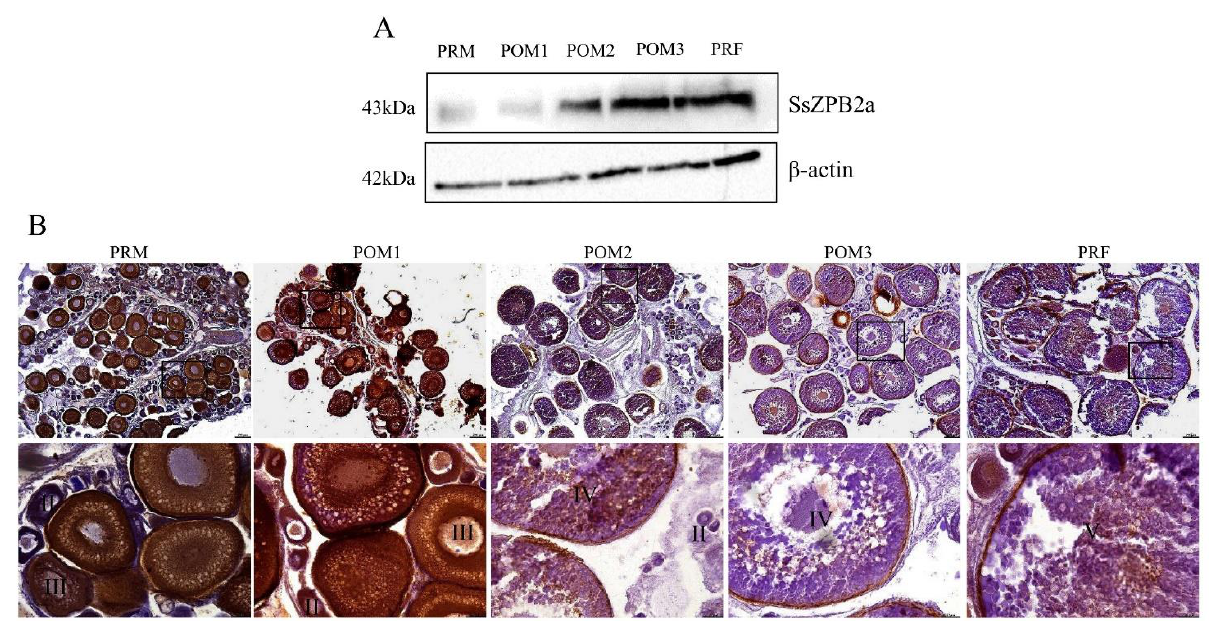
Figure 3. The expression analysis of SsZPB2a in the ovary at different developmental stages at the protein level. ( A ) The expression of SsZPB2a protein during the ovary development (n = 6). ( B ) The immunohistochemistry analysis on the expression of SsZPB2a during ovary development. PRM, pre-mating stage; POM1~POM3, post-mating stage 1~3; PRF, pre-fertilization stage. Scale bar: 200 μm for the low magnification images; 50 μm for the high magnification images.